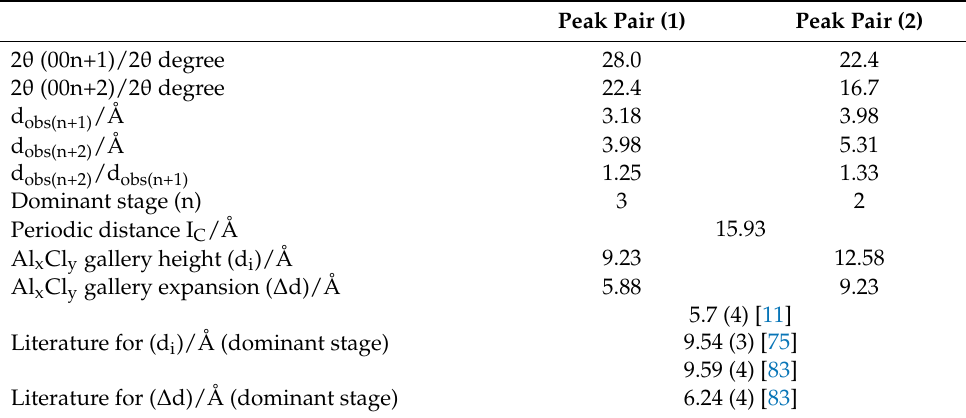
Table 2. Dominant stage and calculated gallery height and expansion from ex situ XRD measurements of charged graphite electrode.